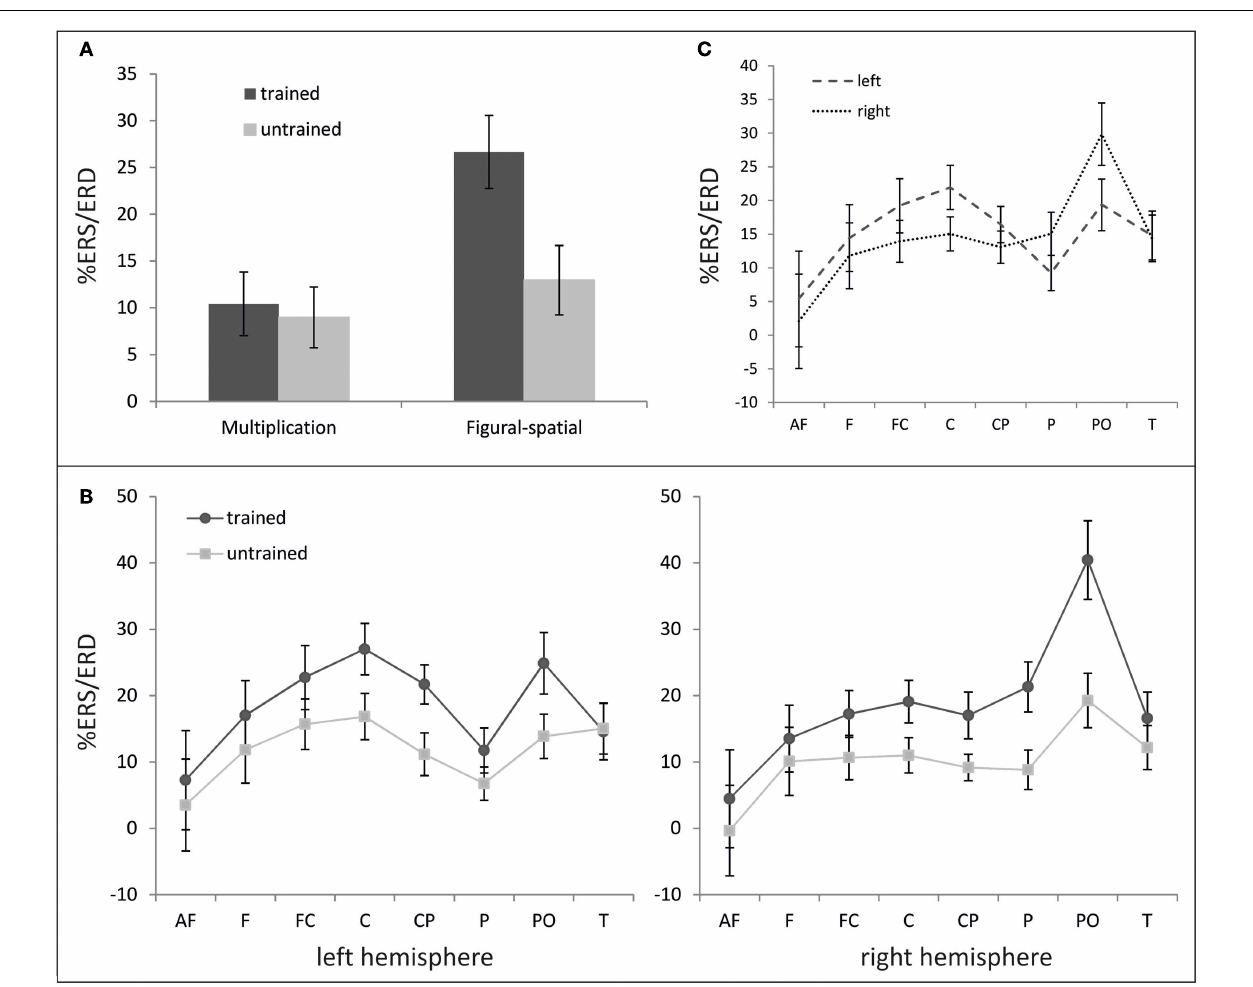
FIGURE 4 | %ERS/ERD in the theta band (3–6Hz). (A) Effect of training as a function of task. (B) Topography of training effect. (C) Hemispheric differences depending on cortical area. Error bars depict 1 SE of the mean. AF, anteriofrontal; F, frontal; FC, frontocentral; C, central; CP, centroparietal; P, parietal; PO, parietooccipital;T,